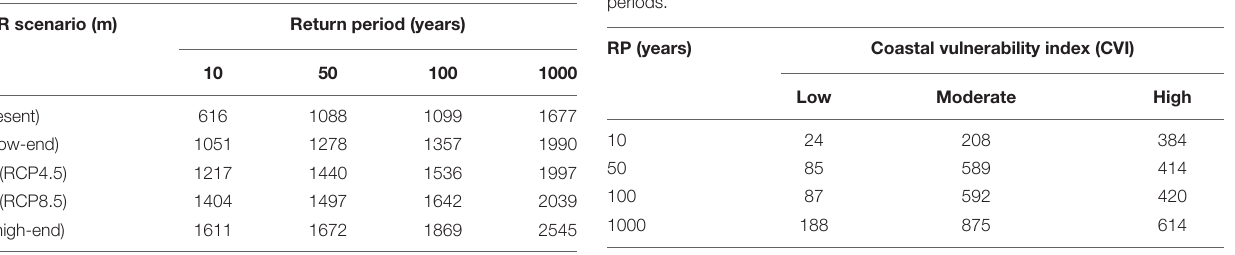
TABLE 3 | Number of landfills located near a coastline with low, moderate, or high coastal vulnerability index (CVI) under water levels associated with different return periods.